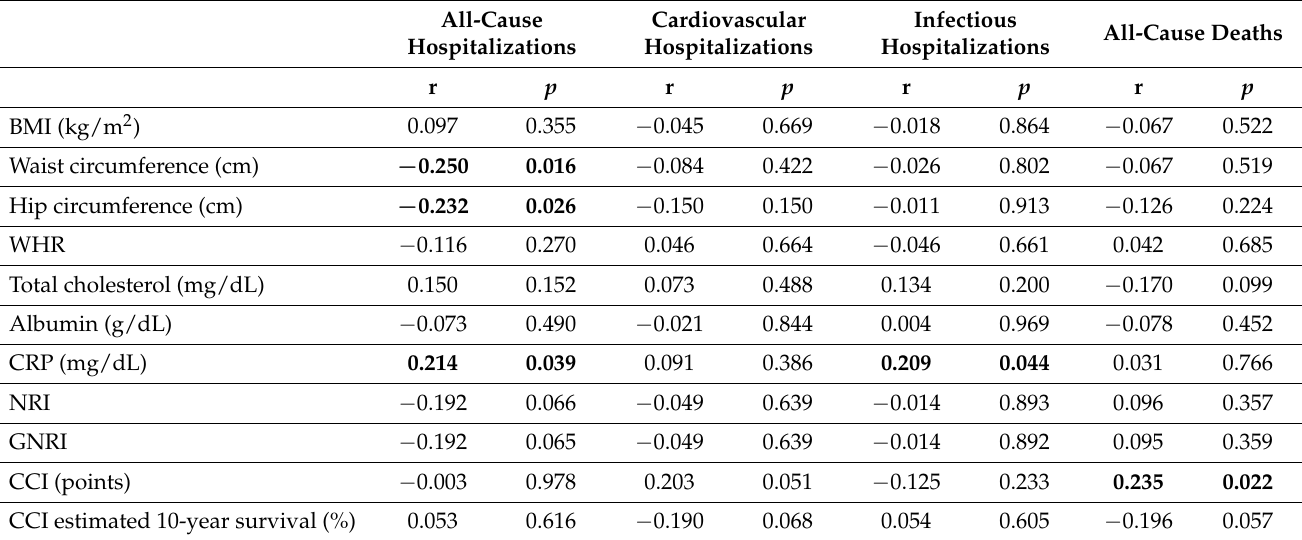
Bolded values are statistically significant. Abbreviations: BMI—body mass index, WHR—waist to hip ratio, CRP—C-reactive protein, NRI—nutritional risk index, GNRI—geriatric nutritional risk index, CCI—Charlson Comorbidity Index. Table 7 contains the results of the quantity associations regarding all-cause, cardiovas- cular, and infectious hospitalizations. In this approach, the number of all-cause hospitaliza- tions significantly negatively correlated with the number of points in the NRI (r = − 0.211;